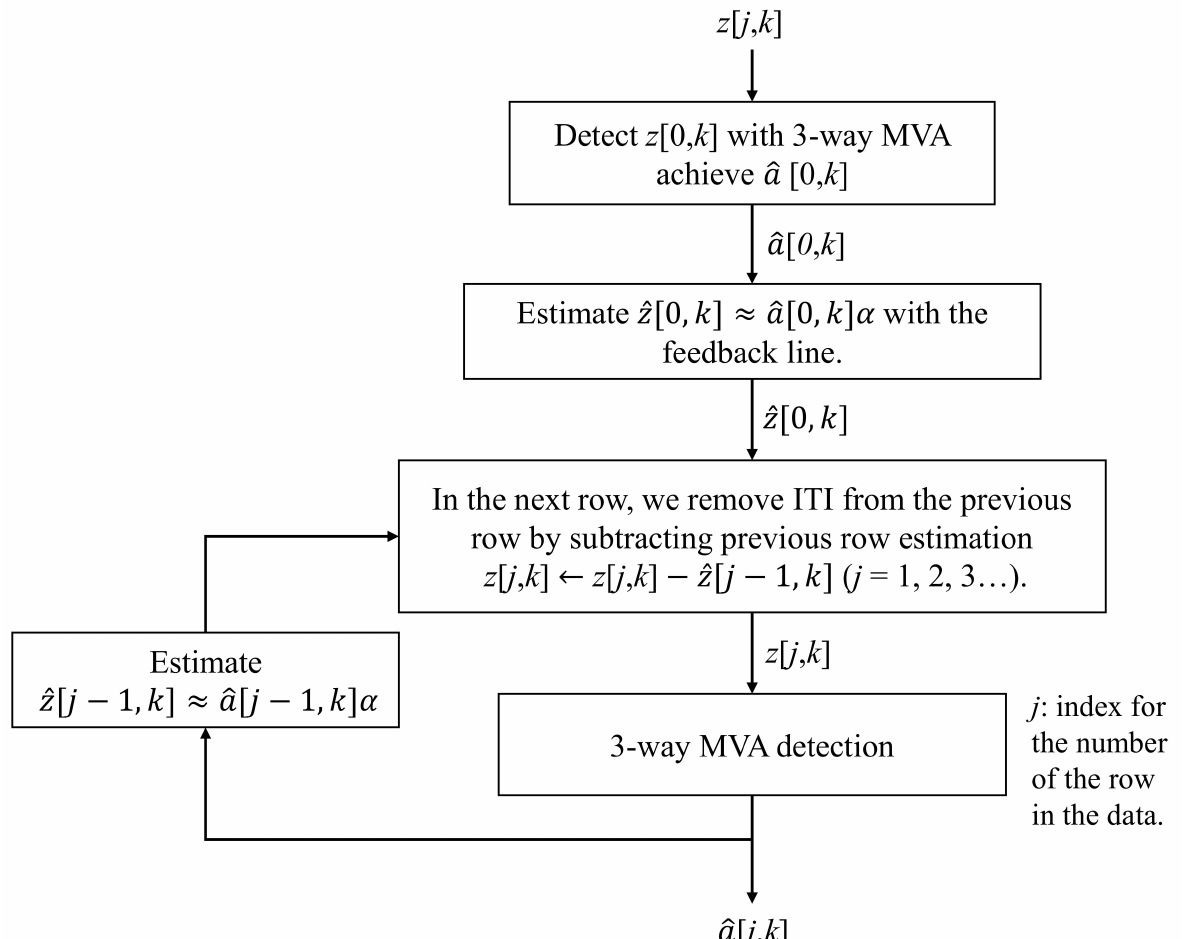
Figure 9. Procedure of three-way MVA with feedback